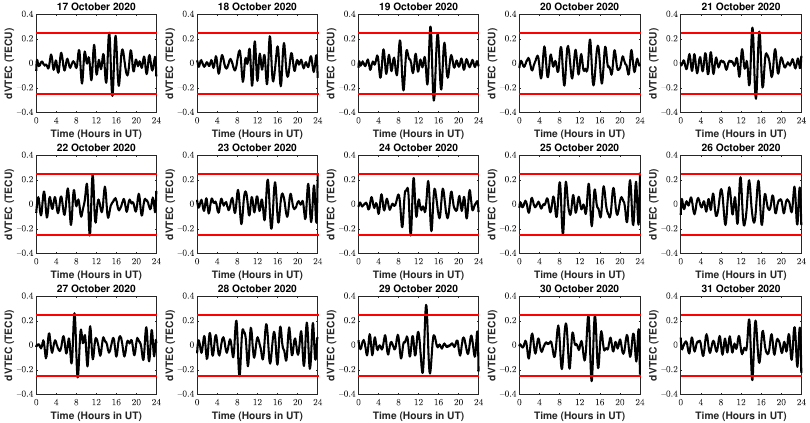
Figure 7. Diurnal variation of dVTEC (black curve) with the un-perturbed levels (red lines) from